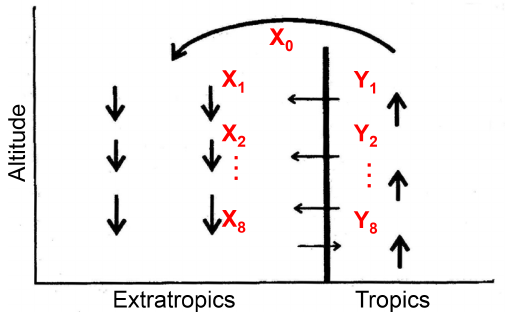
Figure 6. Conceptual two-dimensional circulation model to analyze mixing processes between tropics and extratropics (from Plumb, 2002). The X 0 is the uppermost tropical stratospheric air mass; X i ( i = 1–8) are air masses formed by mixing of X i − 1 and Y i .